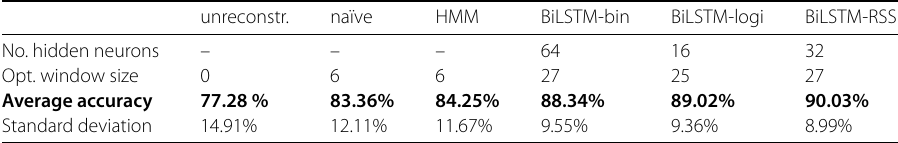
Table 2 Selected optimal hyper-parameters as number (No.) of hidden neurons, optimal (Opt.) window size, average test accuracy values, and the corresponding standard deviations for each model unreconstr. naïve HMM BiLSTM-bin BiLSTM-logi BiLSTM-RSSI No. hidden neurons – – –